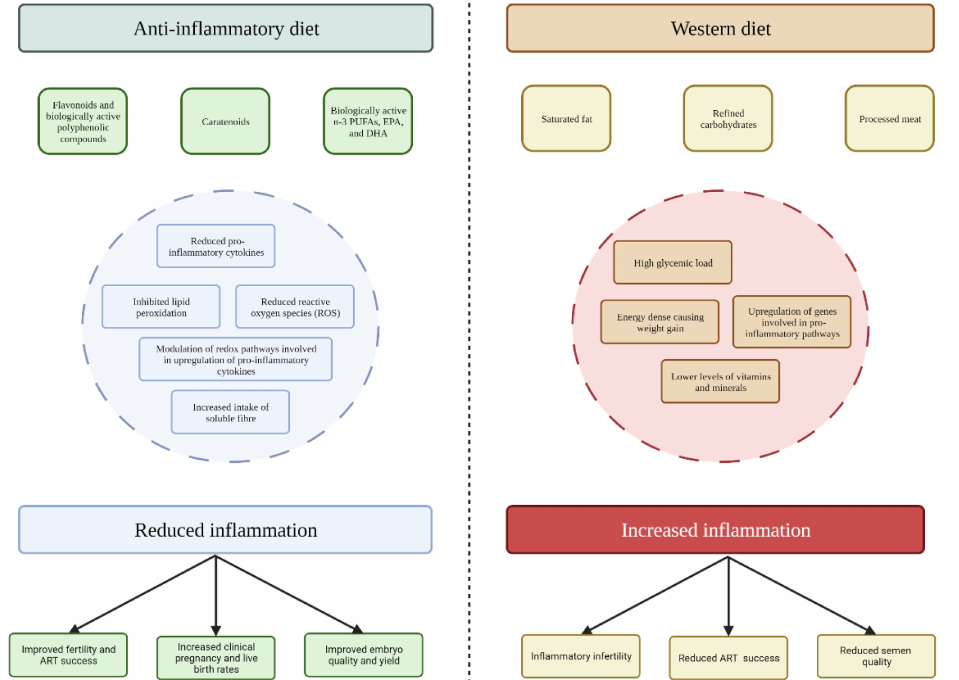
Figure 1. Proposed mechanisms for the impact of anti-inflammatory and Western diets on inflamma- tion and fertility